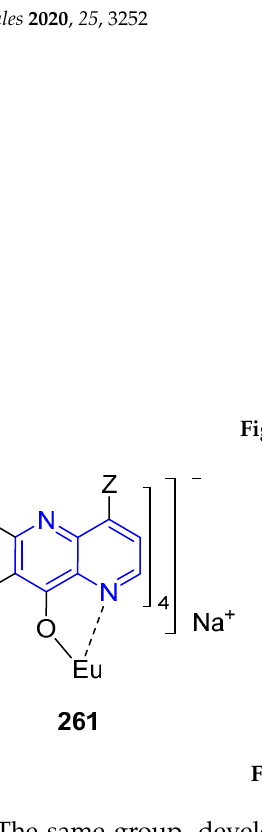
Figure 38. Europium complexes as light emitters.